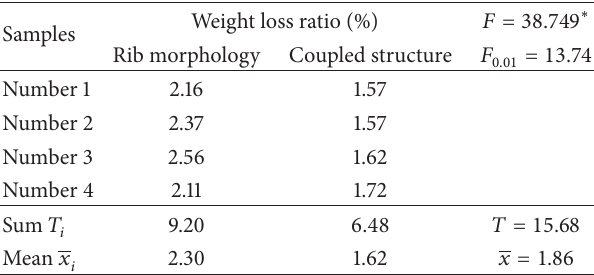
Table 1: Weight loss ratio of samples varied in rib morphology and coupled